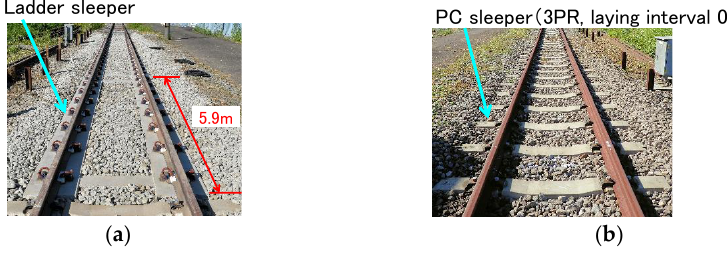
Figure 2. Outline of full-scale models: ( a ) ladder track; ( b ) PC sleeper track.